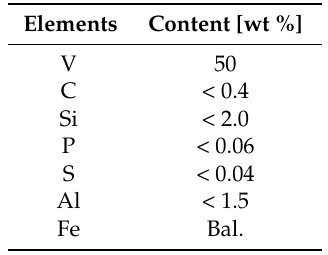
Table 1. Chemical composition of FeV 50 .